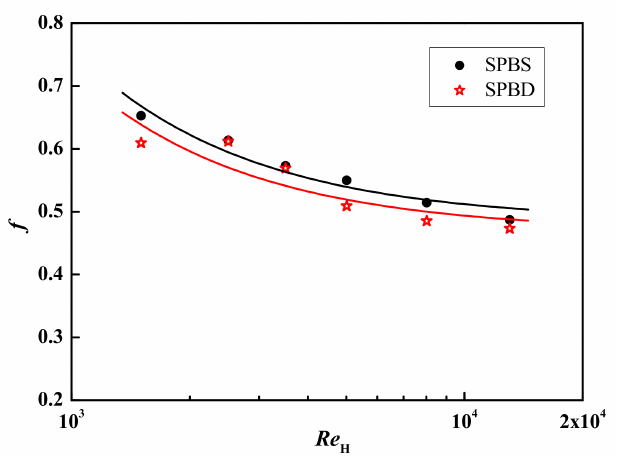
Figure 7. The friction factor of the structured packed bed with smooth or dimpled spheres at N = 1.00.